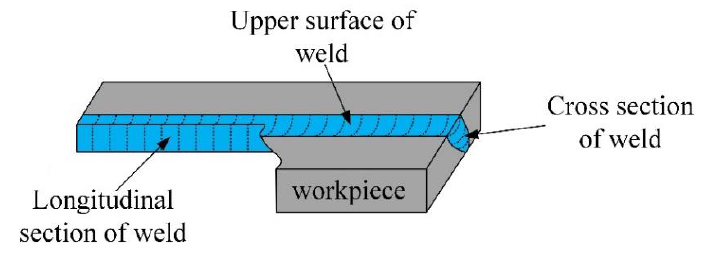
Figure 3. Diagram of each section of the weld.